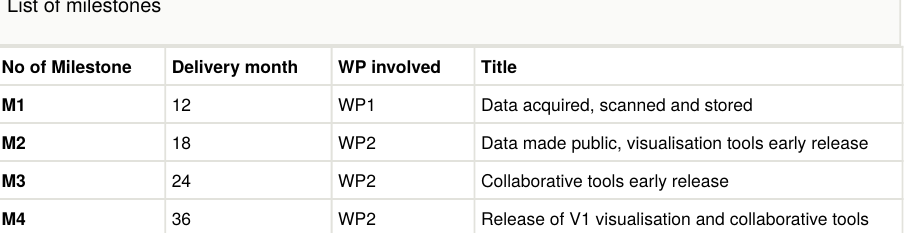
No of Milestone Delivery month WP involved